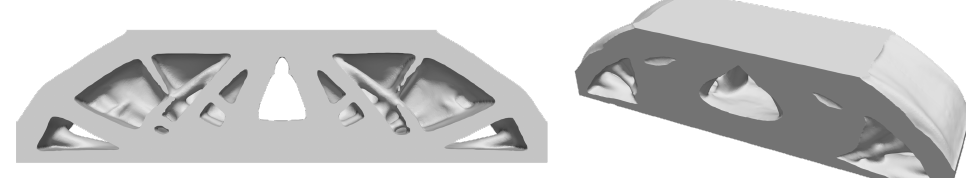
Figure 22. Derived design proposal of the developed optimization method for optimization case 2: Sectional view ( left ) and overall view ( right ).